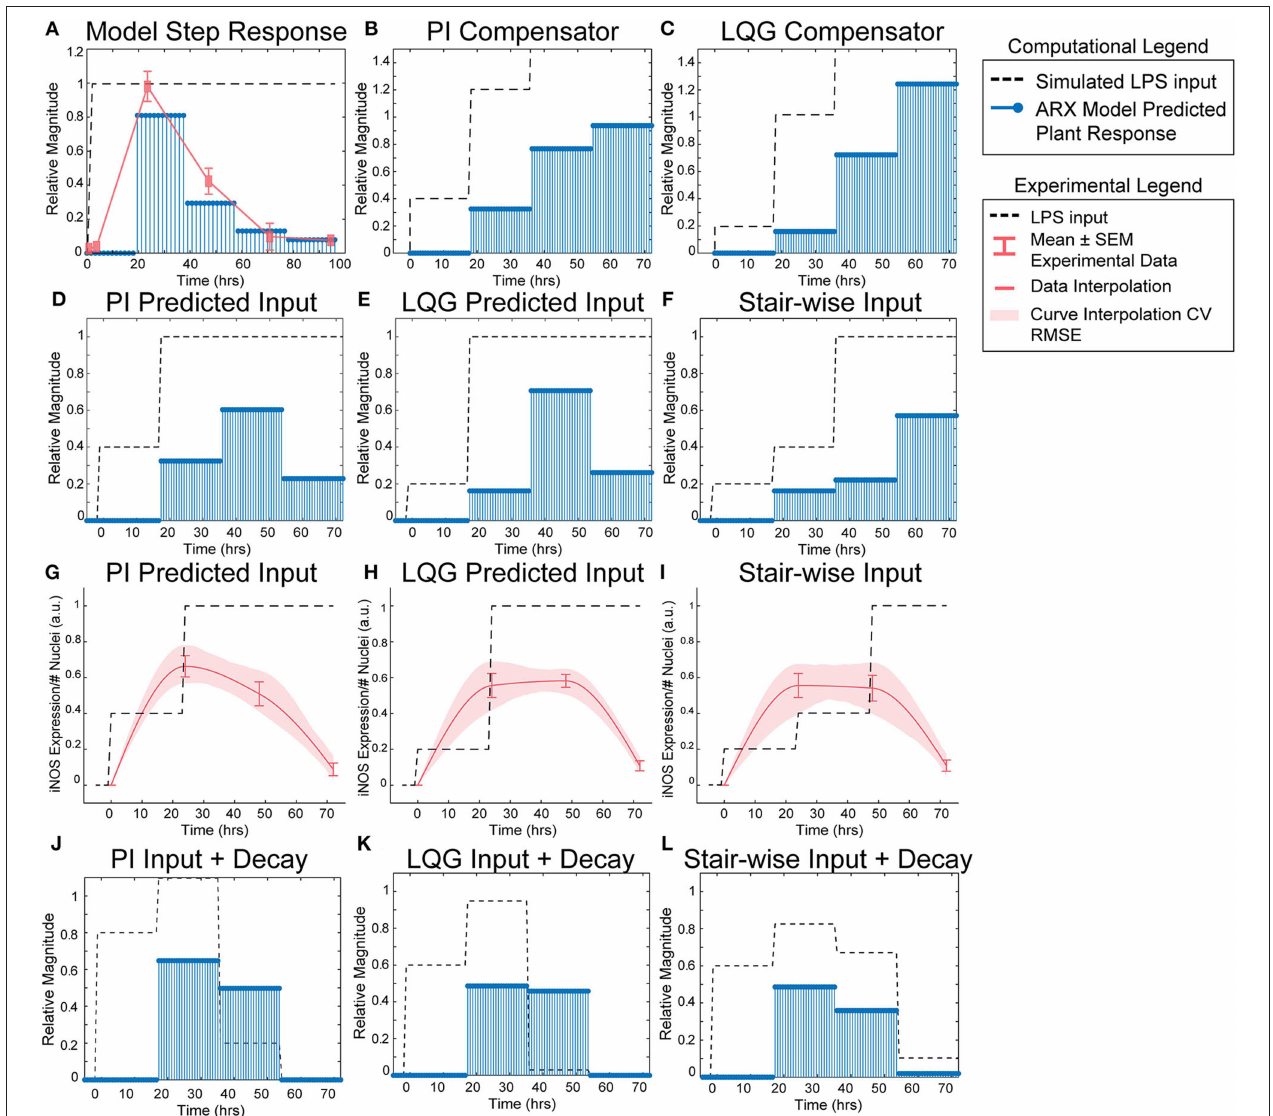
FIGURE 3 | SISO LPS/iNOS ARX model, controller design, and experimental MPC testing. (A) Identified ARX model of macrophage iNOS response to LPS has a characteristic step response that follows the experimentally quantified trajectory. Control system design identifies input strategy (dashed line) for a step reference that elicits a gradual increase in plant response (blue stems) using a (B) PI or (C) LQG controller. Model simulations given controller defined inputs but within experimental input constraints predict sustained outputs for (D) PI and (E) LQG controllers. (F) A heuristically defined three-step increase input strategy predicts an output that reaches a maximum at 72h. Experimental implementation using cultured RAW 264.7 macrophages and (G) PI controller-, (H) LQG controller-, or (I) a heuristic combination of designed LPS input schema (dashed line) modulates temporal iNOS expression (red curves, mean ± SEM, N = 16; interpolated curve ± RMS CV error) but does not reach the unit reference nor sustain 72h activity. Macrophage refractory response to repeated LPS input is captured (blue stems) by multiplying the (J) PI predicted, (K) LQG predicted, or (L) heuristically defined input sequences against a time-dependent exponential decay term (dashed